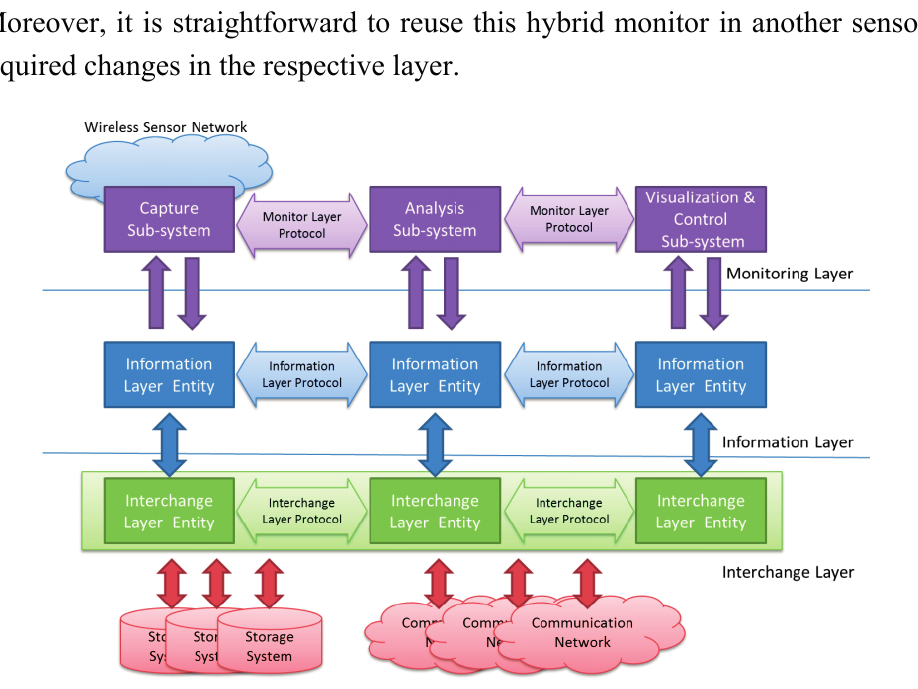
Figure 1. Architecture of the proposed hybrid